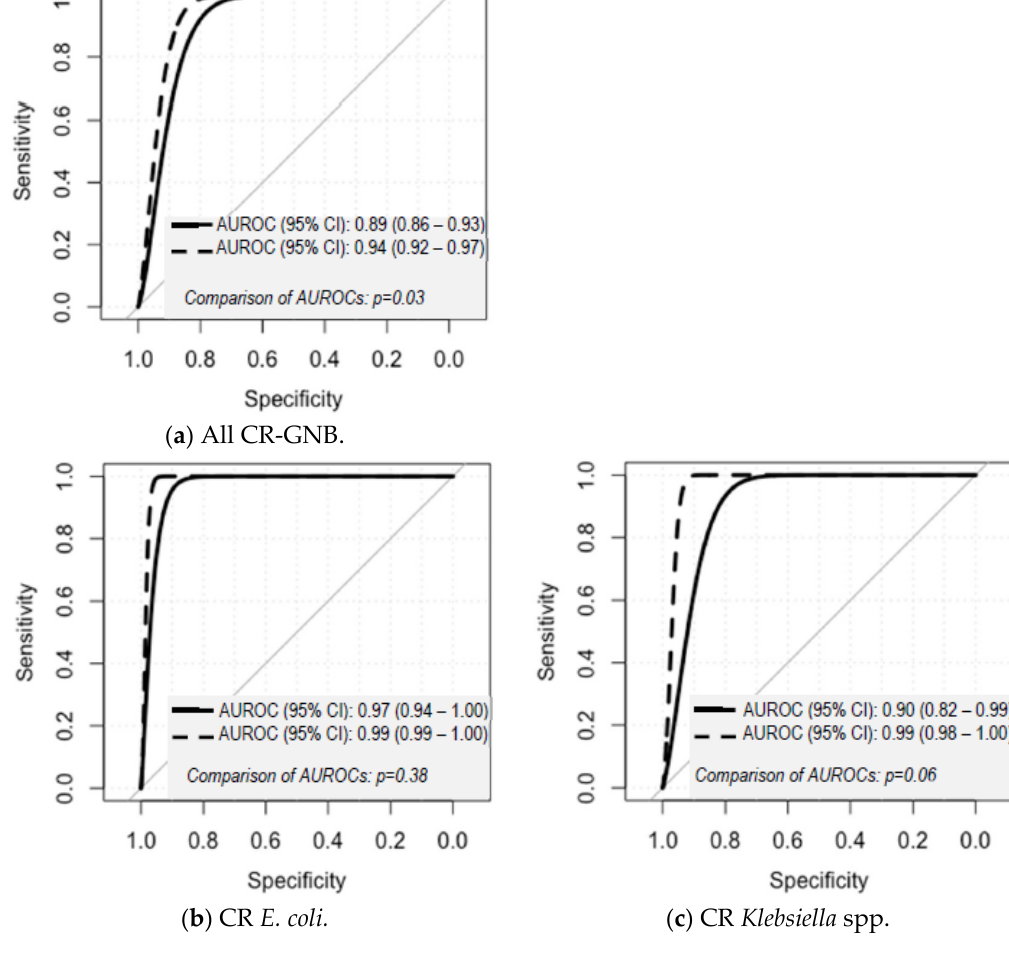
Figure 2. Receiver operating curves (ROC) plots for distinguishing between inhibitory and non-inhibitory activity at different timepoints for ( a ) All CR-GNB, ( b ) CR E. coli , ( c ) CR Klebsiella spp., ( d ) CR A. baumannii , and ( e ) CR P. aeruginosa with and without apyrase (2 U / mL) in 24 h time–kill studies (TKSs).